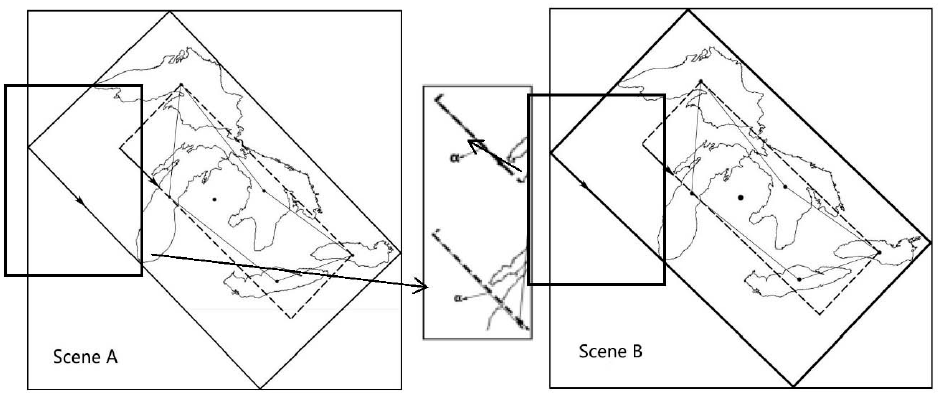
Figure 16. Relative direction angle of Scene A and Scene B.